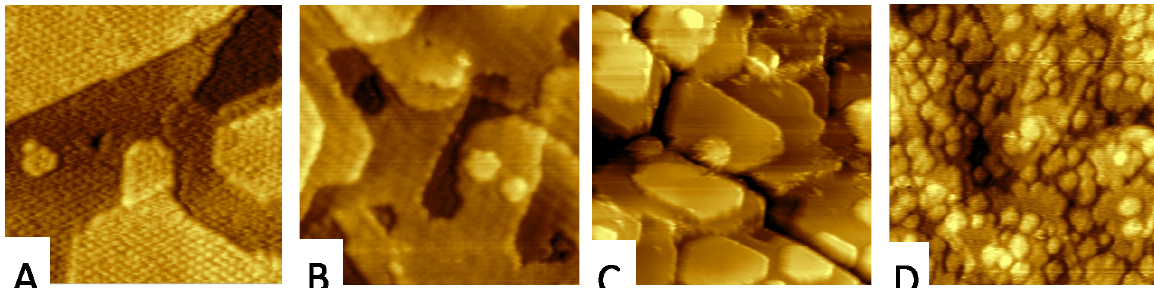
Figure 7. STM micrographs of oxidation of Ce 2 O 3 layer on Cu(111). ( A ) the starting Ce 2 O 3 layer; ( B , C ) the morphology upon reoxidation; ( C ) reoxidation causes cracking of the ceria layer revealing up to 2% of the Cu substrate; ( D ) upon homoepitaxy of 0.3 ML ceria on the sample from ( B ) at RT and annealing in oxygen at 800 K. Image width ( A , B , D ) 45 nm; ( C ) 90 nm.